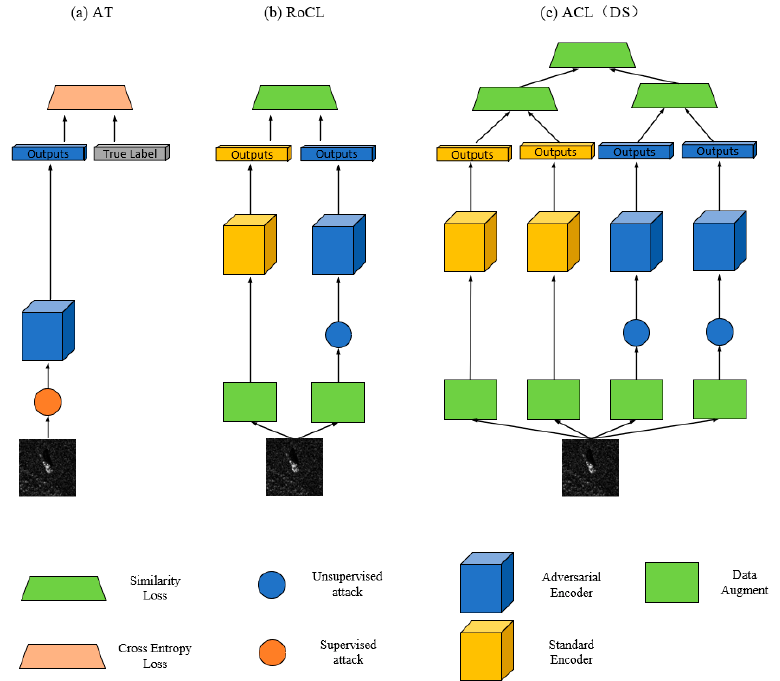
Figure 3. Illustration of workflow comparison: ( a ) AT; ( b ) RoCL; ( c ) ACL(DS). Note that RoCL and ACL(DS) share all weights; however, adversarial and standard encoders use independent BN parameters.